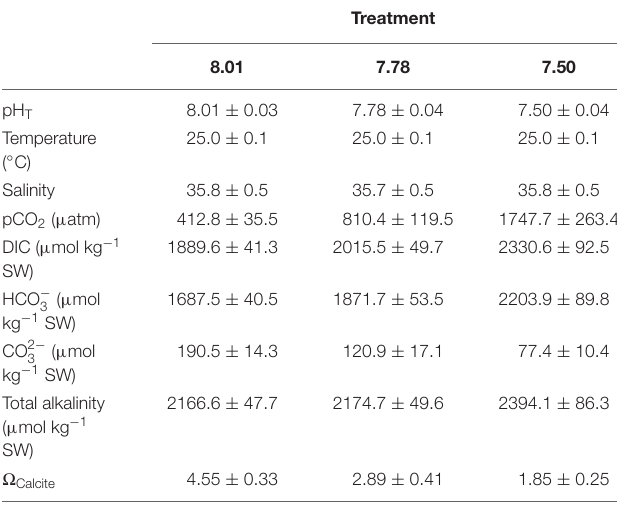
TABLE 1 | Seawater chemistry parameters (means ± standard